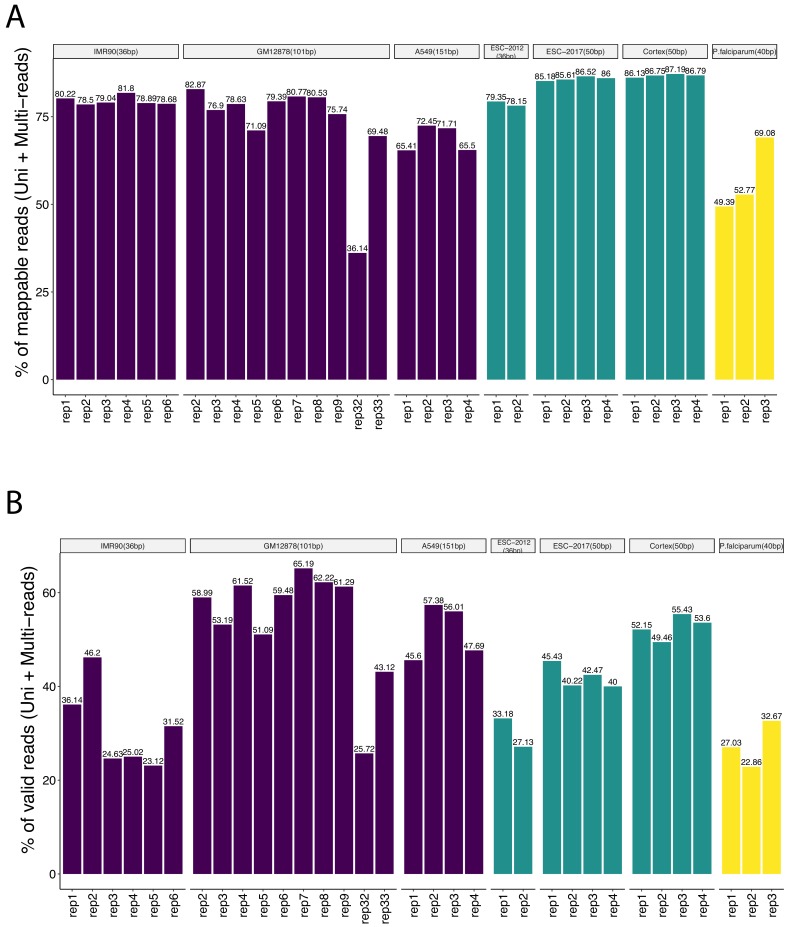
Percentages of (A) mappable and (B) valid reads over the set of all reads for individual replicates of the study datasets as an indicator of data quality.Both the aligned uni-reads and multi-reads are taken into consideration.